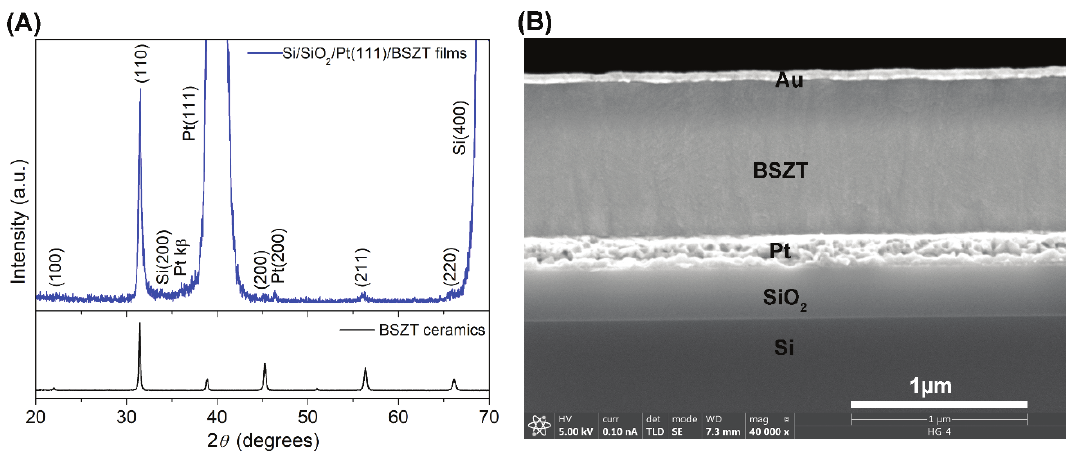
Figure 1. ( A ) The X ray-di ff raction (XRD) patterns of the Ba 0.3 Sr 0.7 Zr 0.18 Ti 0.82 O 3 (BSZT) films. ( B ) The